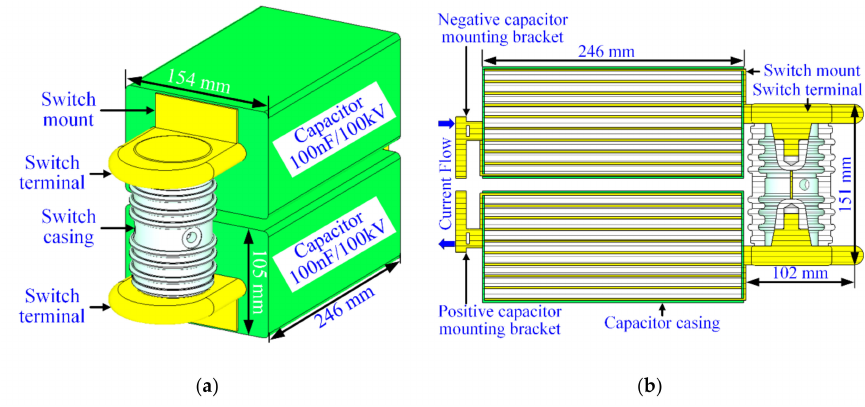
Figure 6. Initial simplified model of the discharge brick. ( a ) Perspective view, ( b ) cut-away